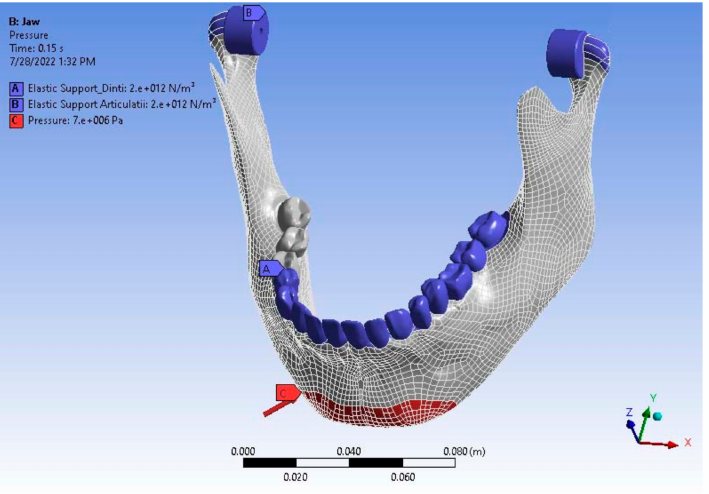
Figure 4. The boundary conditions for the frontal (chin) impact with three missing teeth (first, second and third molars). A: elastic support teeth; B: elastic support temporomandibular joints; C: pressure 7 × 10 6 Pa. The convergence of the solution was determined by the mesh density. No adaptive mesh has been used due to the limitations in computational